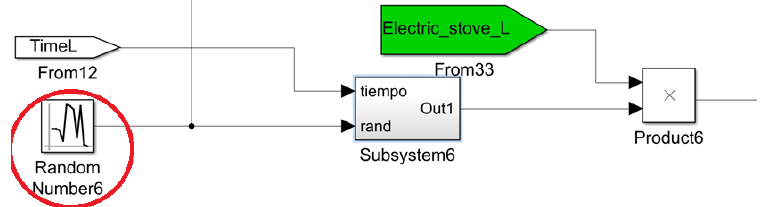
Figure 7. Model structure, random